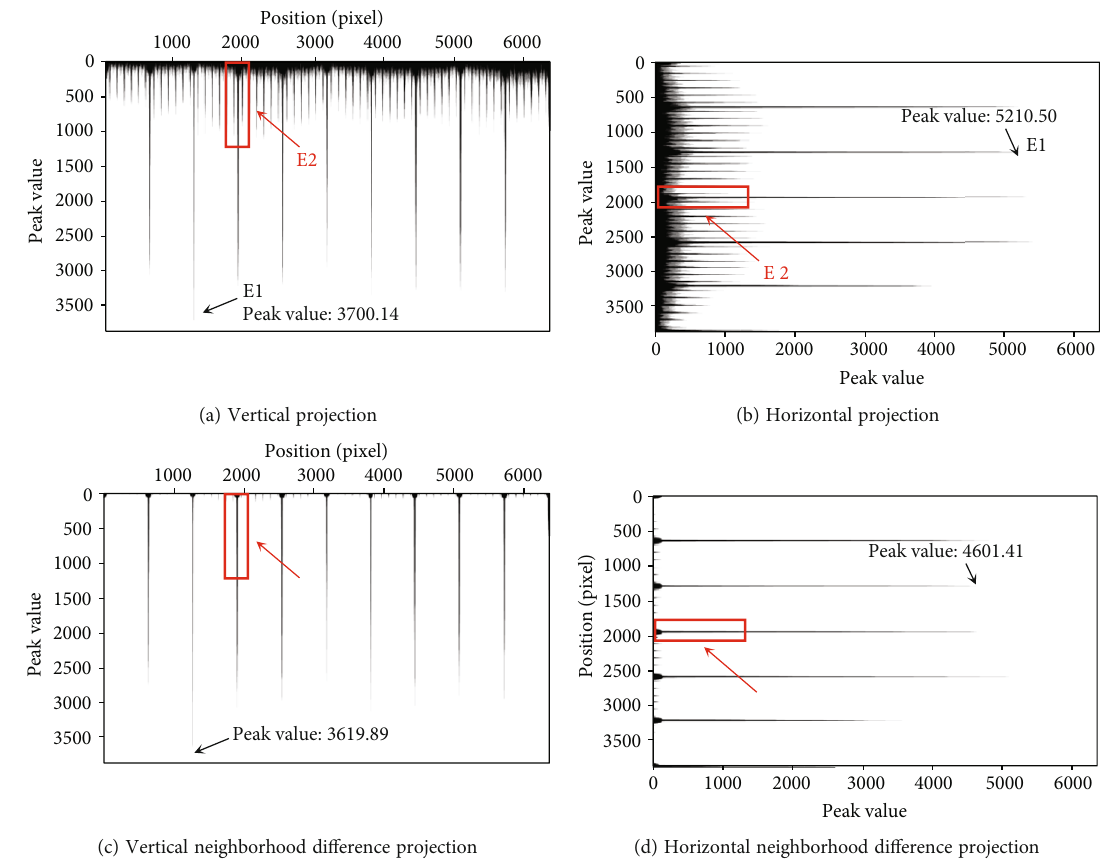
Figure 5: Projection of edge binarized image with LDEEP of SCC.